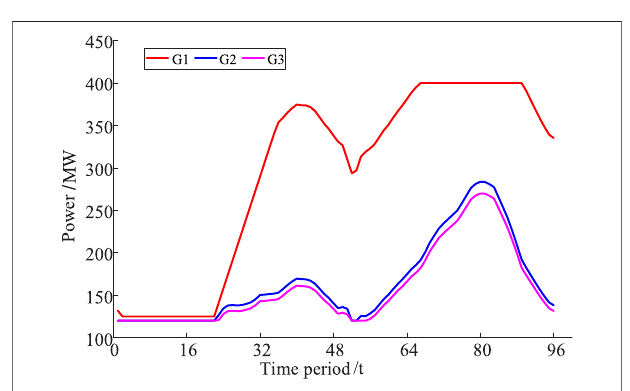
FIGURE 5 | Day-ahead planned output curves of thermal power units.